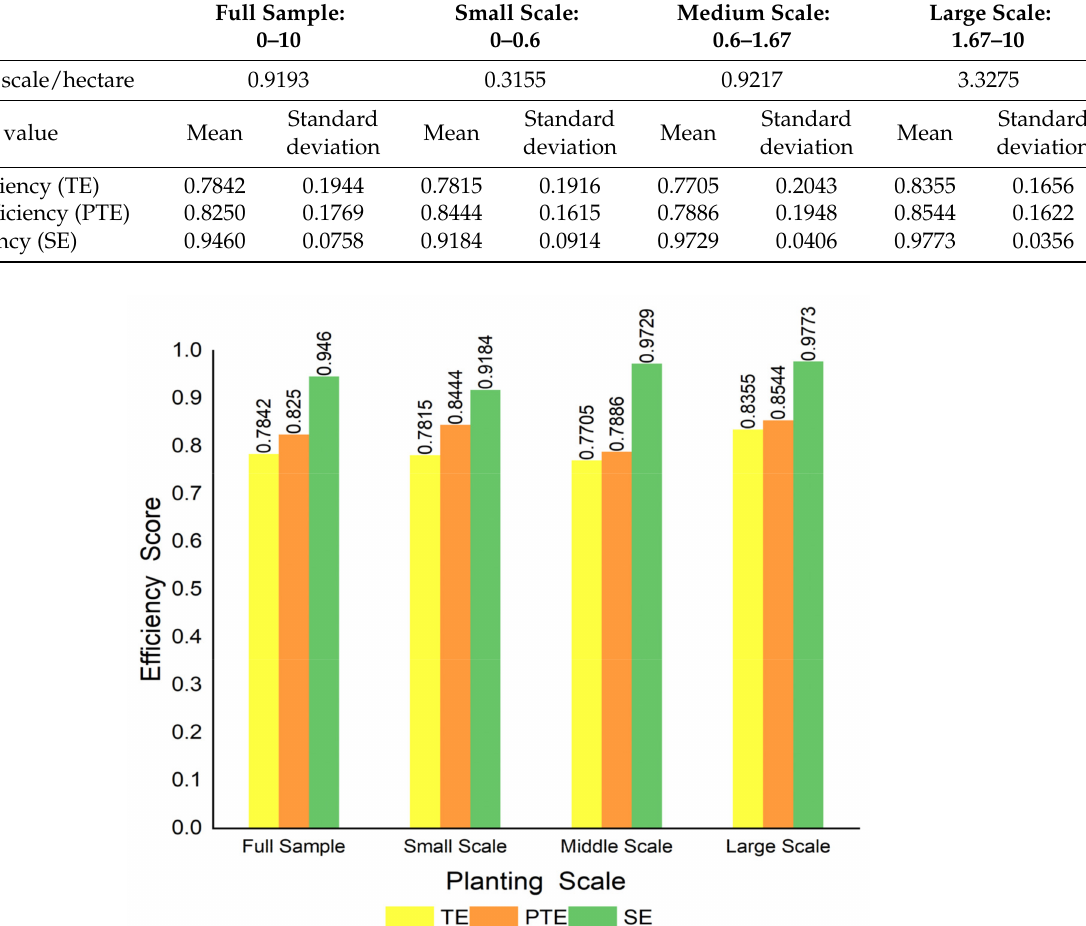
Table 3. Production efficiency values of farmer households based on different farming scales.